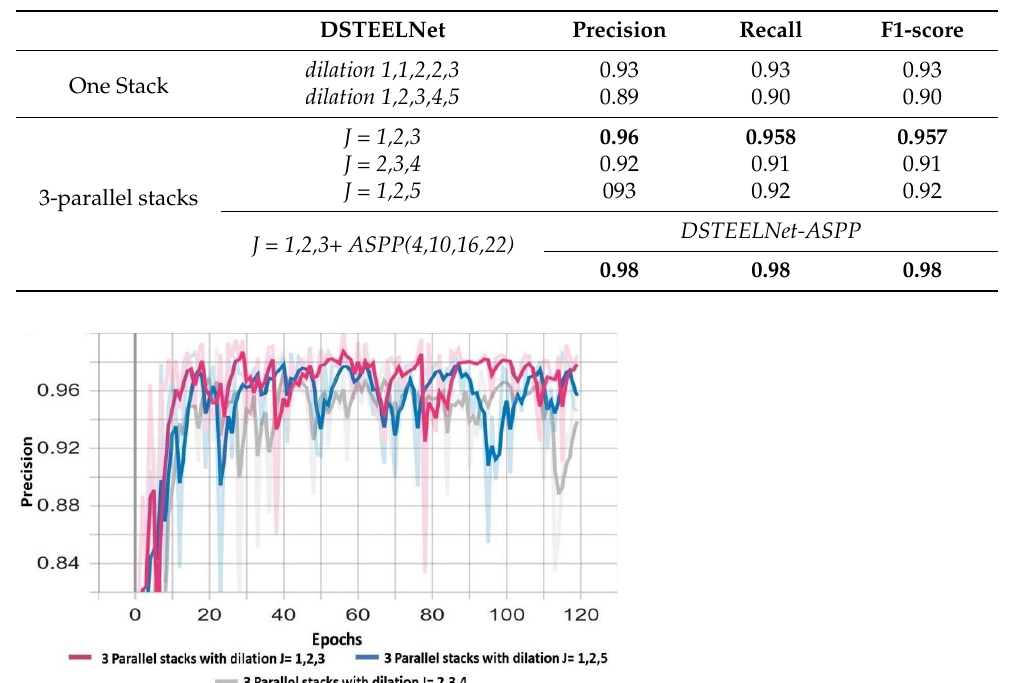
Table 6. Weighted average results for different DSTEELNet architectures with different dilated rates.